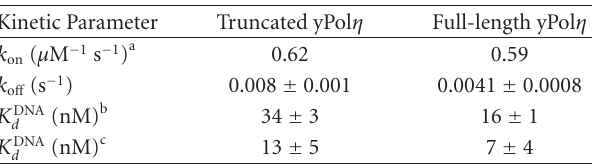
Table 2: Rate and equilibrium dissociation constants for the binary complex yPol η · DNA at 23 ◦